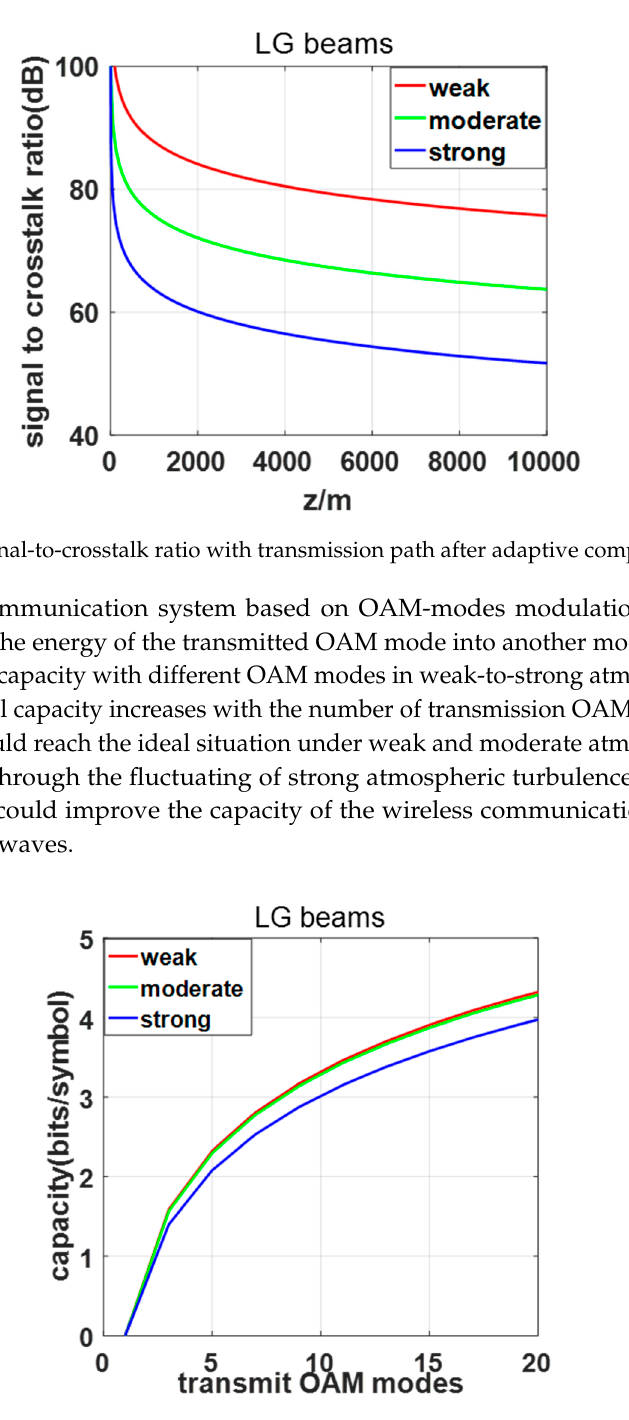
( c ) Figure 9. Crosstalk distribution of electromagnetic vortex waves with transmission distance of ( a ) 1 km, ( b ) 5 km and ( c ) 10 km under moderate-to-strong turbulence conditions.